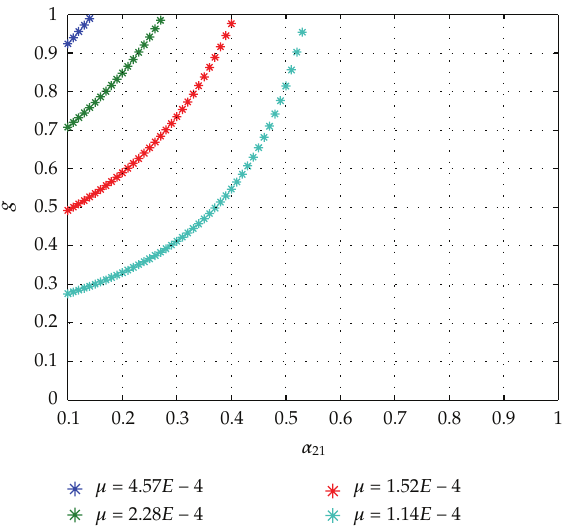
Figure 10: The e ff ect of di ff erent μ on g e